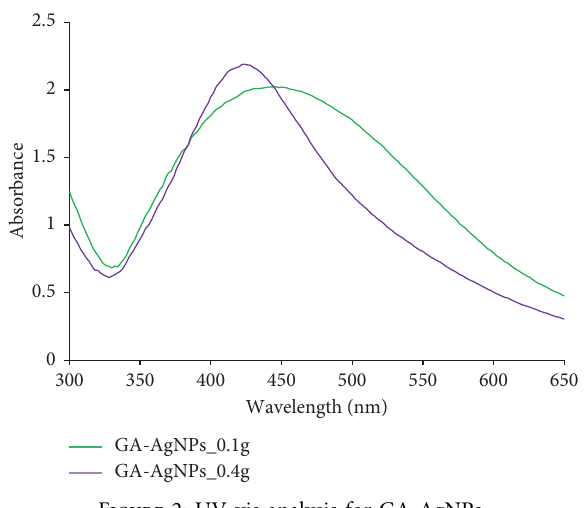
Figure 1: Synthesis of GA-AgNPs using an autoclave method. Te solutions containing AgNO AgNPs_0.1g and GA-AgNPs_0.4g, before and after autoclaving for 20min.